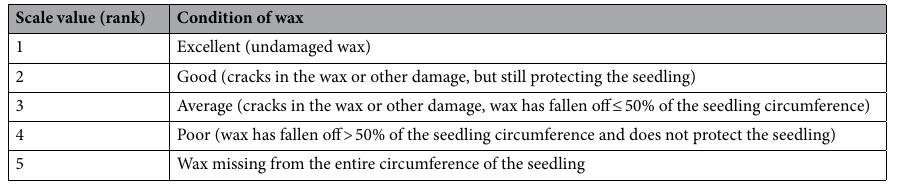
Table 2. Wax condition